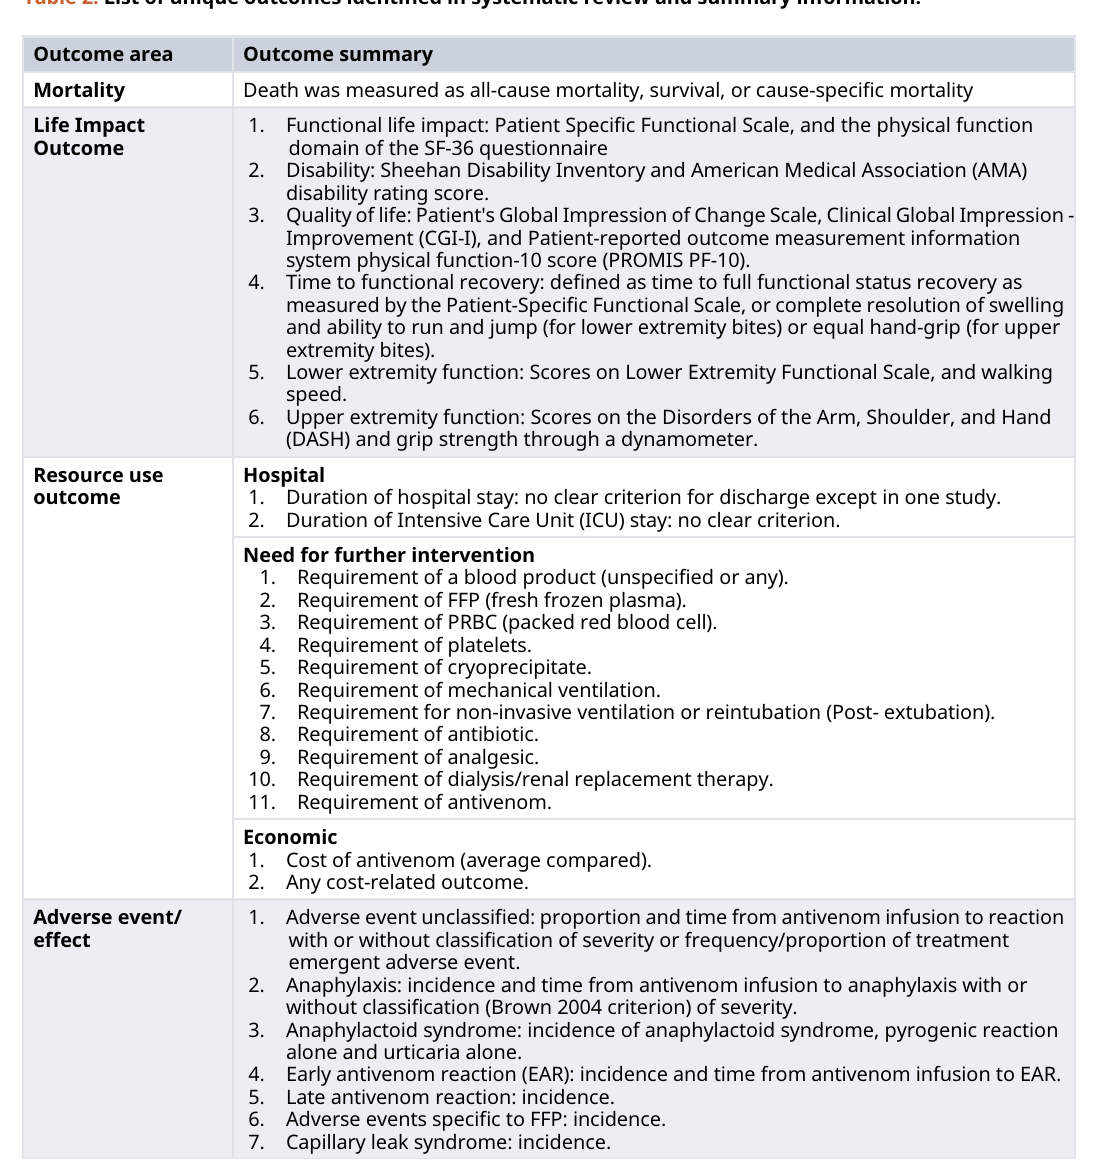
Table 2. List of unique outcomes identified in systematic review and summary